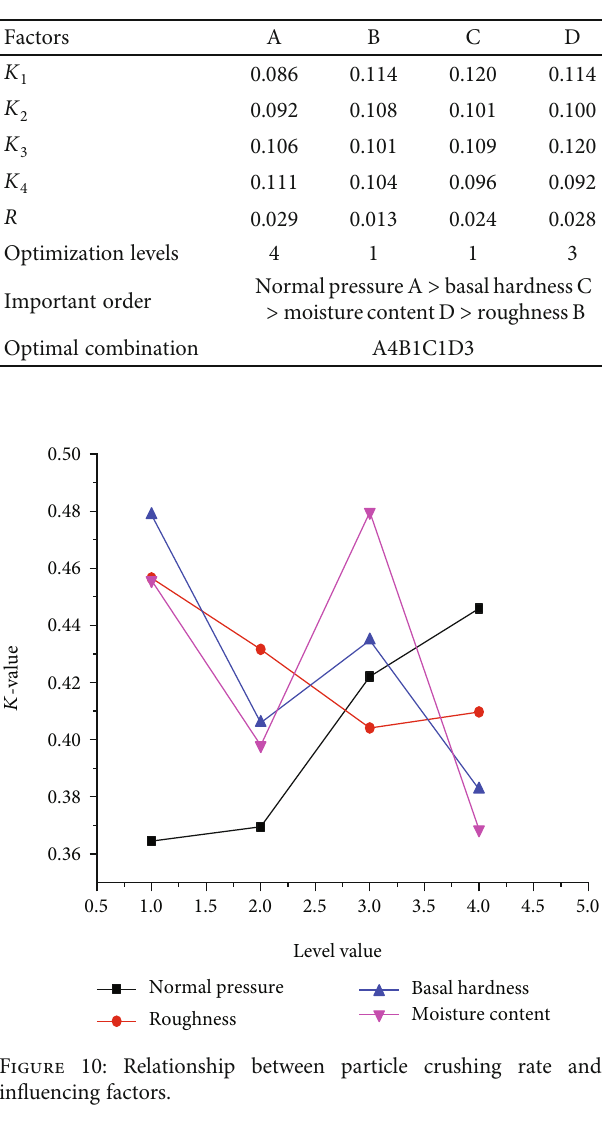
Table 7: Visual analysis of shear particle crushing rate on the interface.